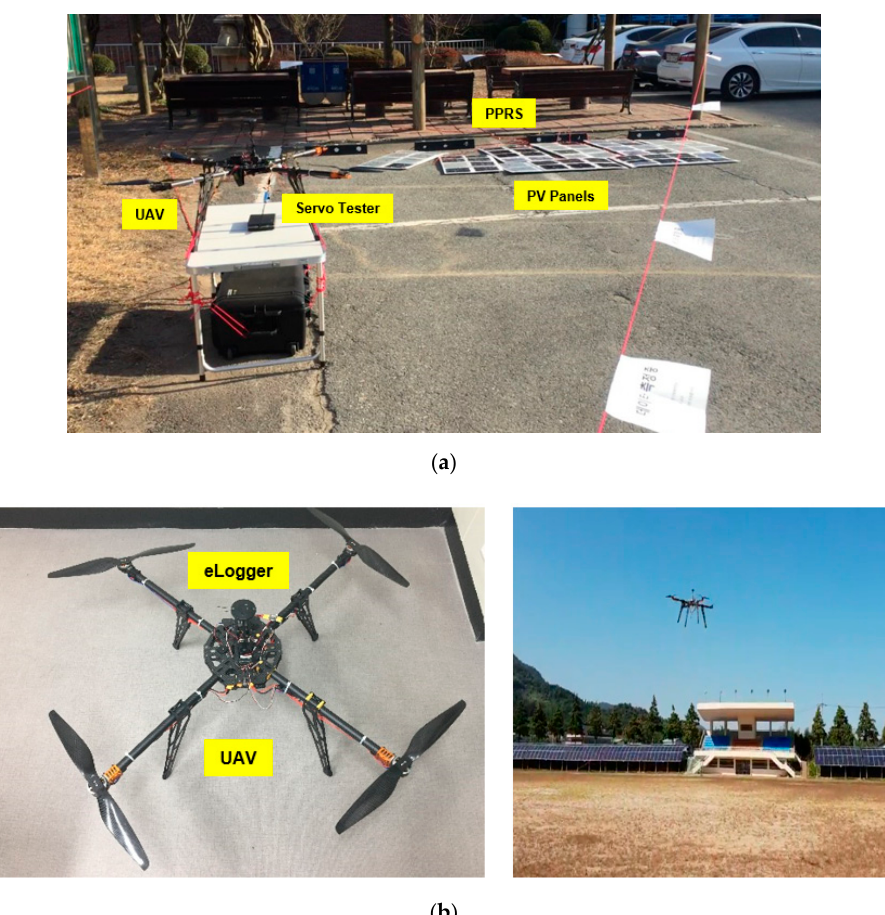
Figure 8. Outdoor experiments of PV panels and UAVs: ( a ) PV panels and ( b ) UAVs.